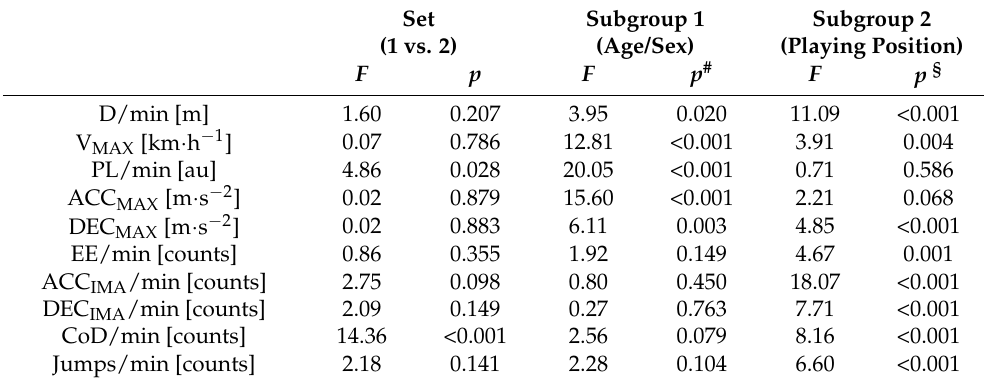
Table 2. Overview of statistical effects of age/sex and playing position on variables